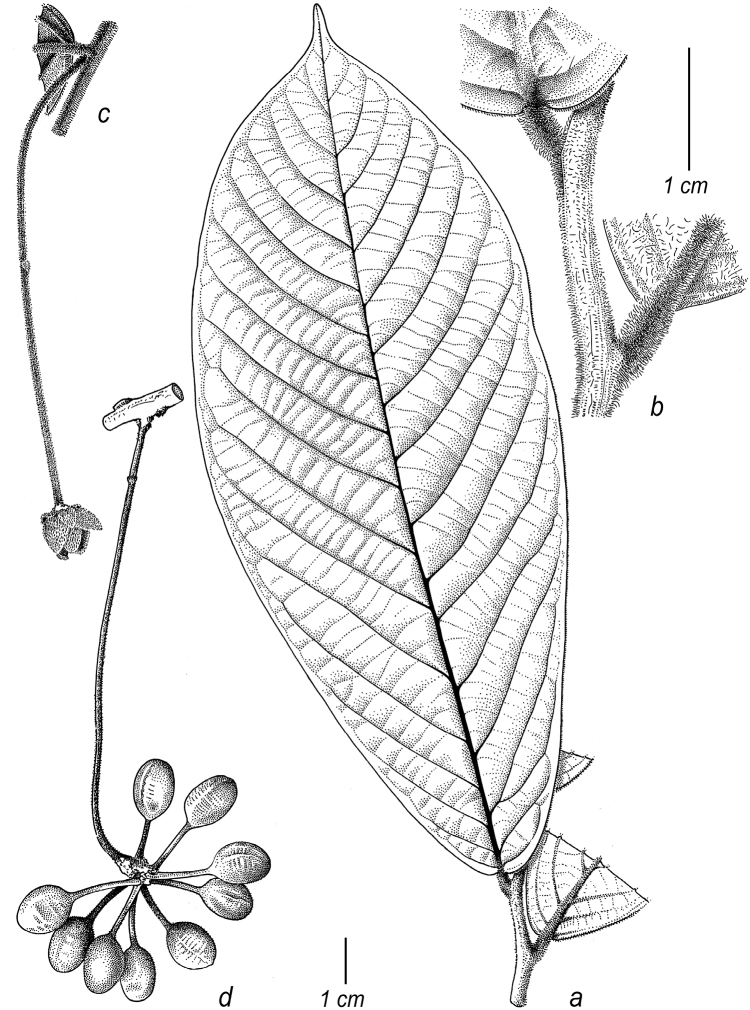
Cremastospermabullatum Pirie a leaf b leaf base c flower d fruit (a–cVásquez et al. 24891dJaramillo, N. et al. 972).